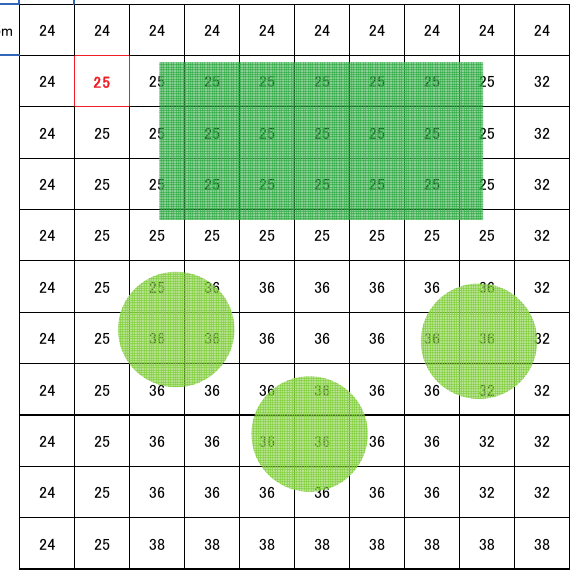
Figure 1. Structure of 5m mesh